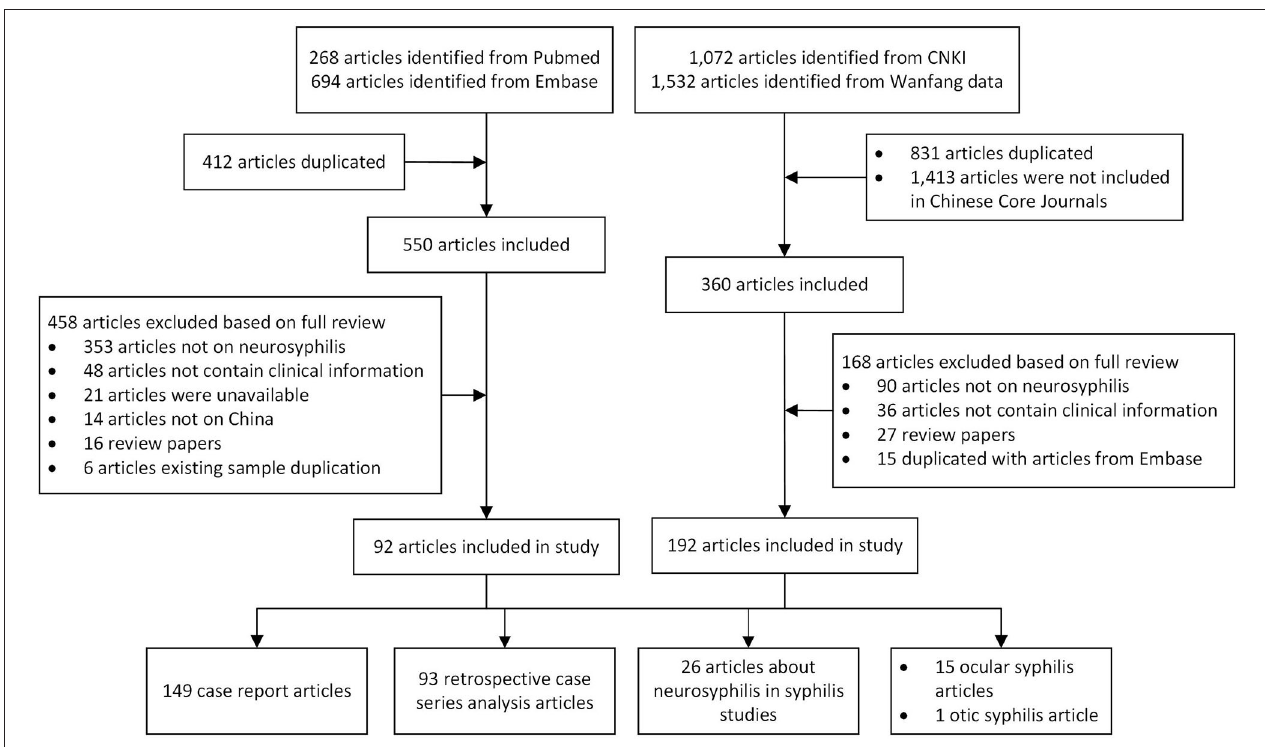
FIGURE 1 | Study inclusion